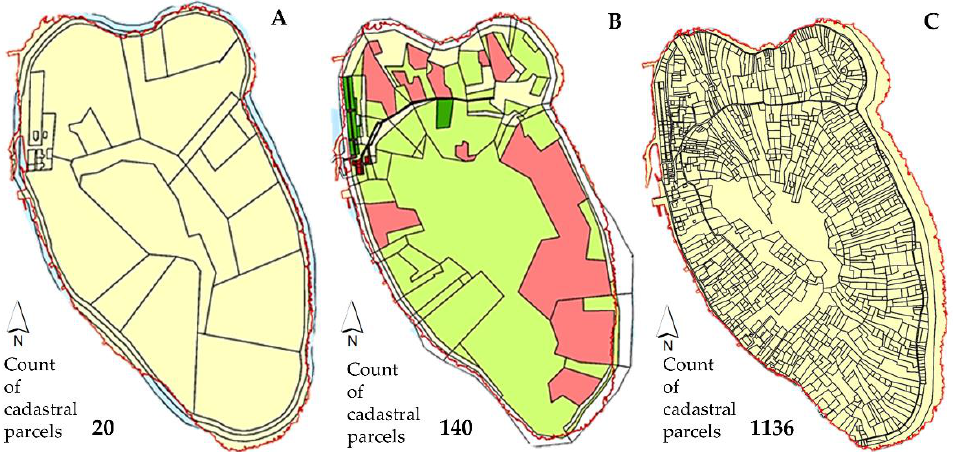
Figure 22. Fragmentation of cadastral parcels for the 1776–2021 period.